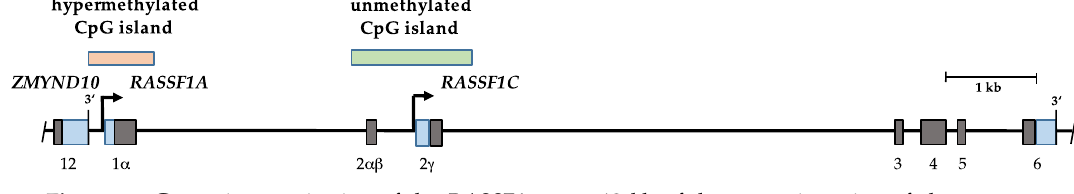
Figure 1. Genomic organization of the RASSF1 gene. 12 kb of the genomic region of chromosome 3p21.3 (hg19: 50,379,000–50,367,000) is shown. Exons are numbered and depicted as black and blue boxes indicating coding and untranslated regions, respectively. The RASSF1A isoform is transcribed from a CpG island containing 84 CpG sites, that is often hypermethylated in cancer. Transcription of RASSF1C initiates a downstream located CpG island consisting of 139 CpGs. Transcription start sites are indicated with arrows and transcription end sites are marked with 3 ′ . ZMYND10 represents the last exon (12) of the zinc finger MYND-type containing 10 gene, which is located 200 bp upstream of RASSF1A promoter.